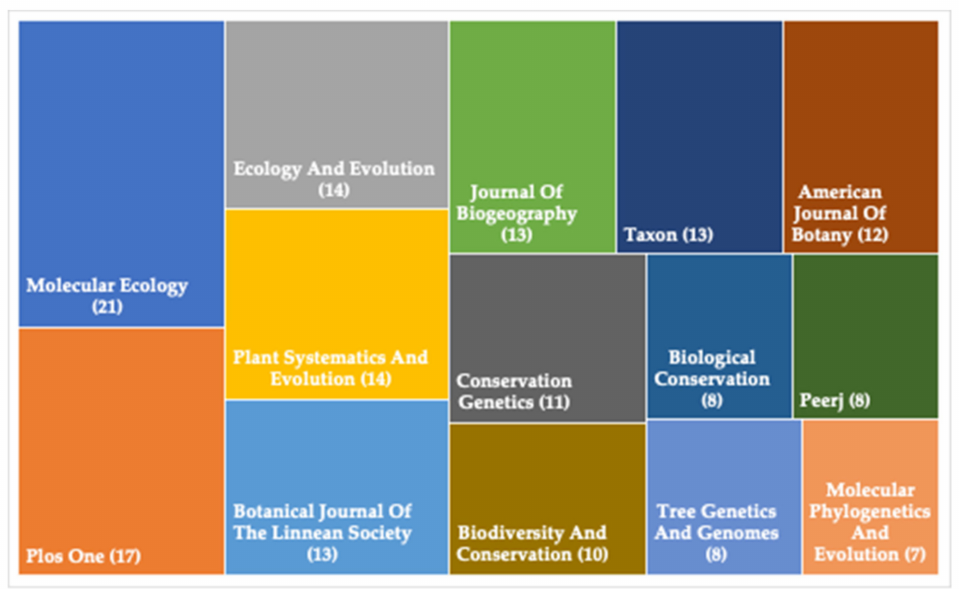
Figure 1. Number of documents per journal regarding the initial Scopus search using the keywords “plant conservation”, “phylogeography” and “Mediterranean”. Only journals with more than six published papers are